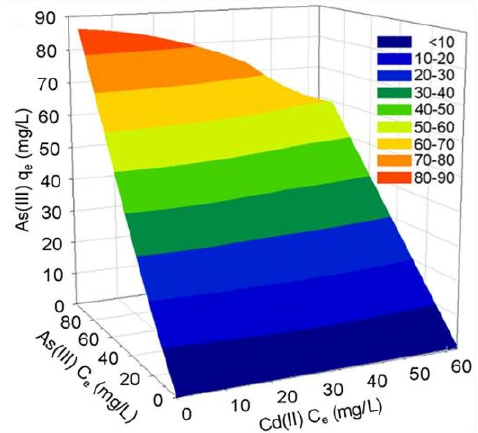
Figure 24. Effect of initial Cd(II) concentration on the adsorption capacity of α -FeOOH@BC for As(III) [62]. Reprinted with permission from Sihang Zhu et al. (2020). Copyright 2020, Springer.